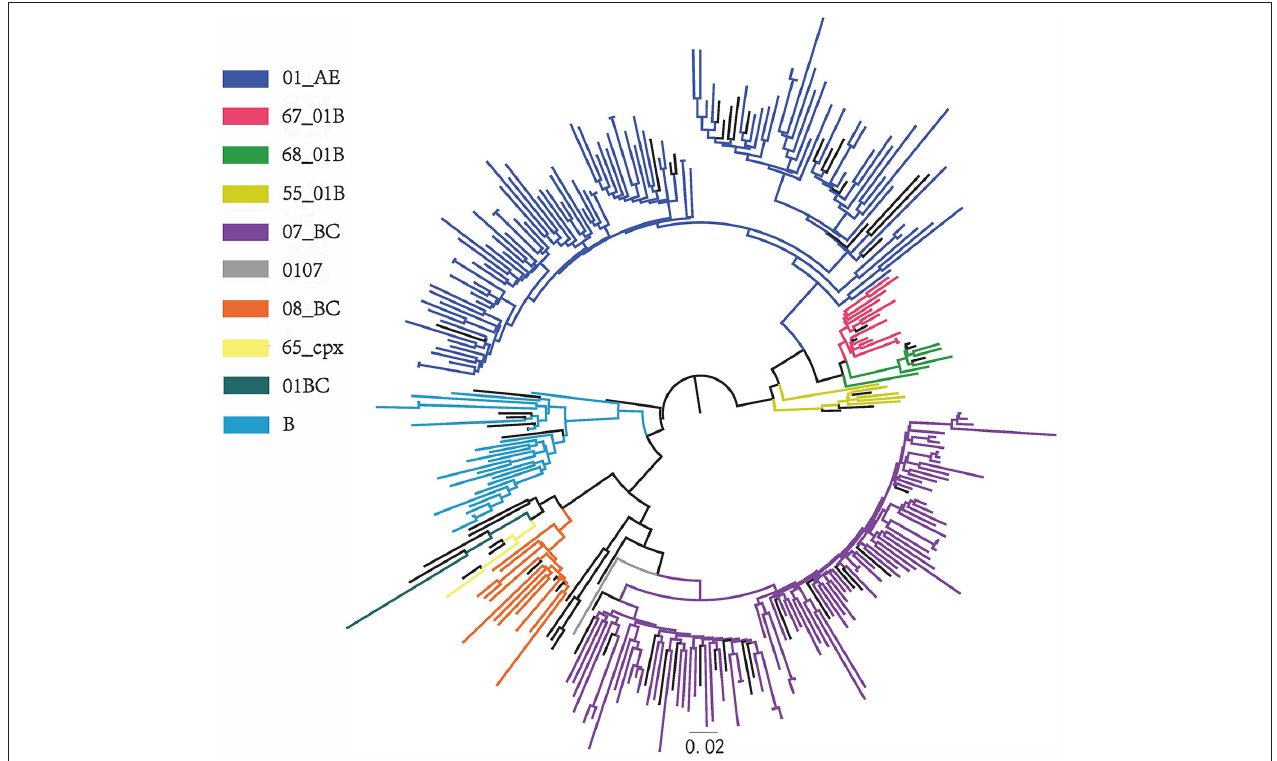
FIGURE 2 | Phylogenetic tree. Phylogenetic tree was constructed from 242 pol gene sequences of LLV patients in Jiangsu province and reference sequences by FastTree software, with parameters as GTR + G + I replacement model and Bootstrap value ≥ 0.90.